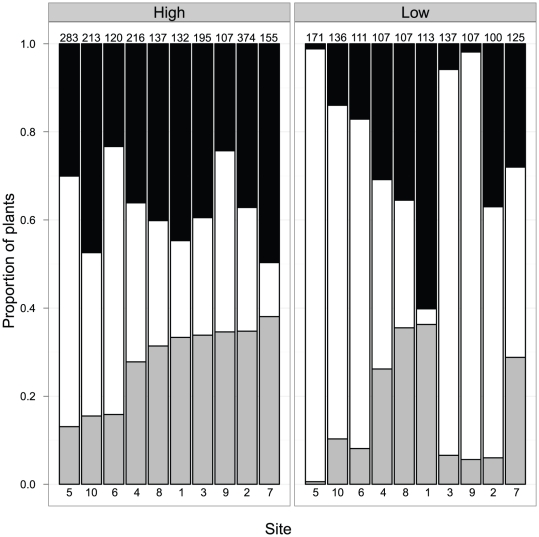
Variation in the frequency of females (grey bar segments), hermaphrodites (white bar segments), and males (black bar segments) at each high density (left panel) and low density (right panel) subsite.Subsites in each panel are ordered by the local frequency of females in the high-density subsites. Numbers at the top of each bar indicate the total sample size per subsite. Numbers at the bottom of each bar correspond with the site numbers in Fig. 1.